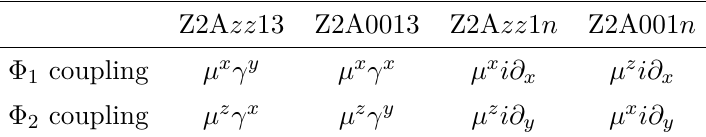
Table 3 . Yukawa couplings of the two adjoint Higgs fields which realize the symmetry fractional- ization of the proximate translationally-invariant spin